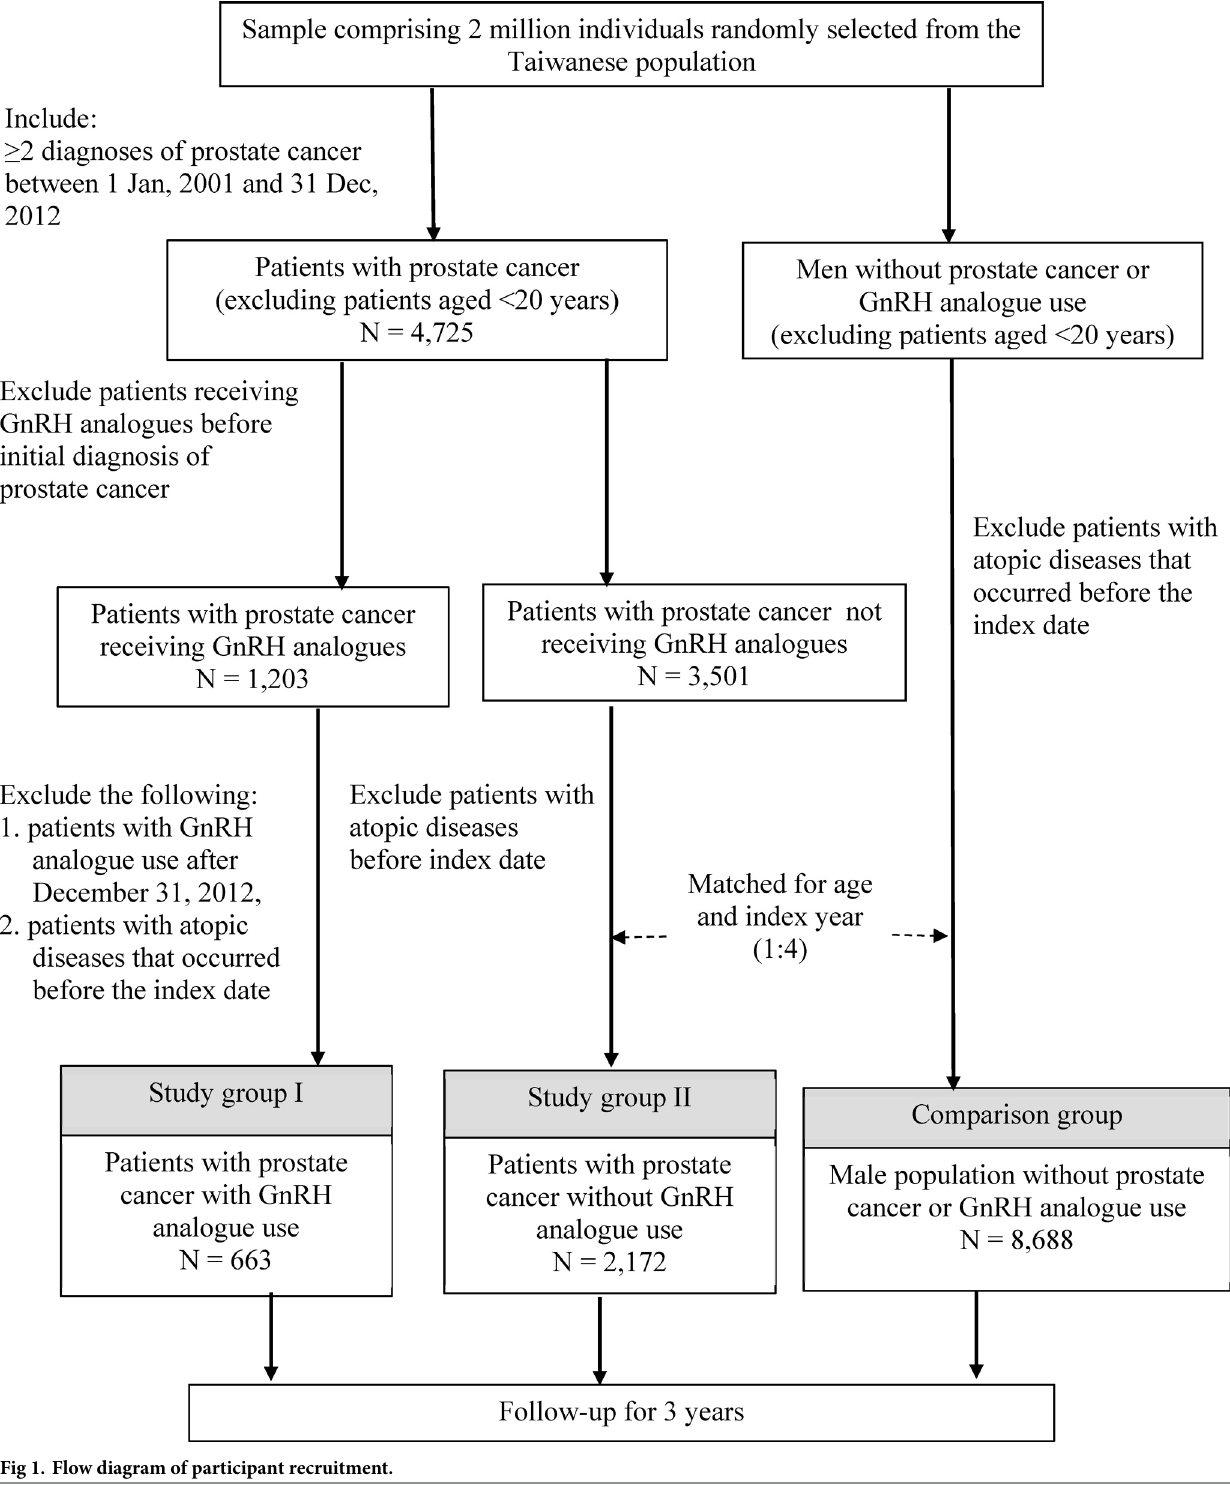
PLOS ONE | https://doi.org/10.1371/journal.pone.0266771 April 11,